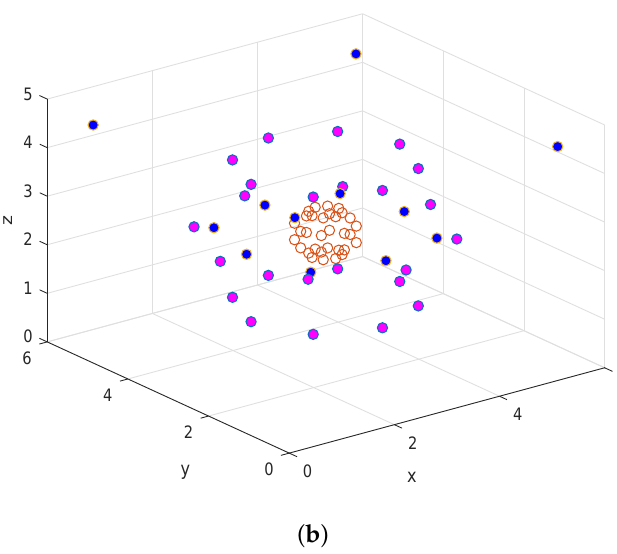
Figure 5. Two different array setups, when the noise source moves around a sphere, where in both setups, pink points are the primary source positions, blue points are loudspeaker positions, and red points are microphone positions: ( a ) Case 3; ( b ) Case 4.